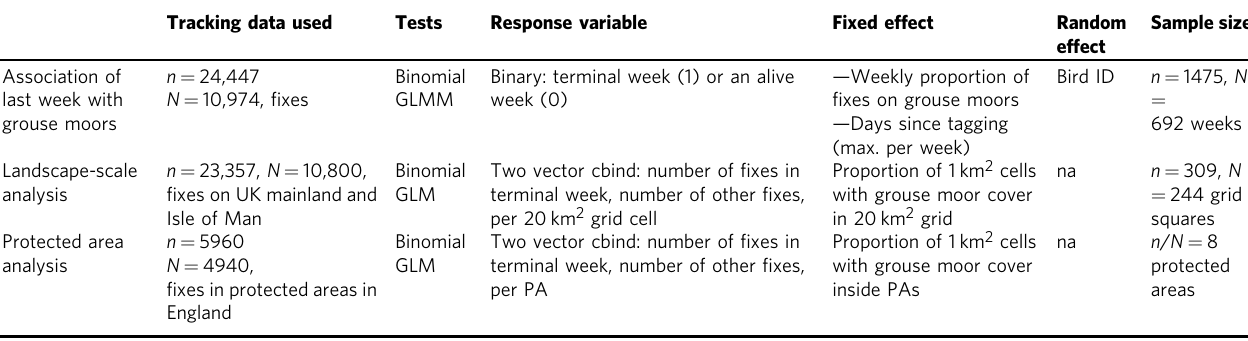
Table 2 Analyses